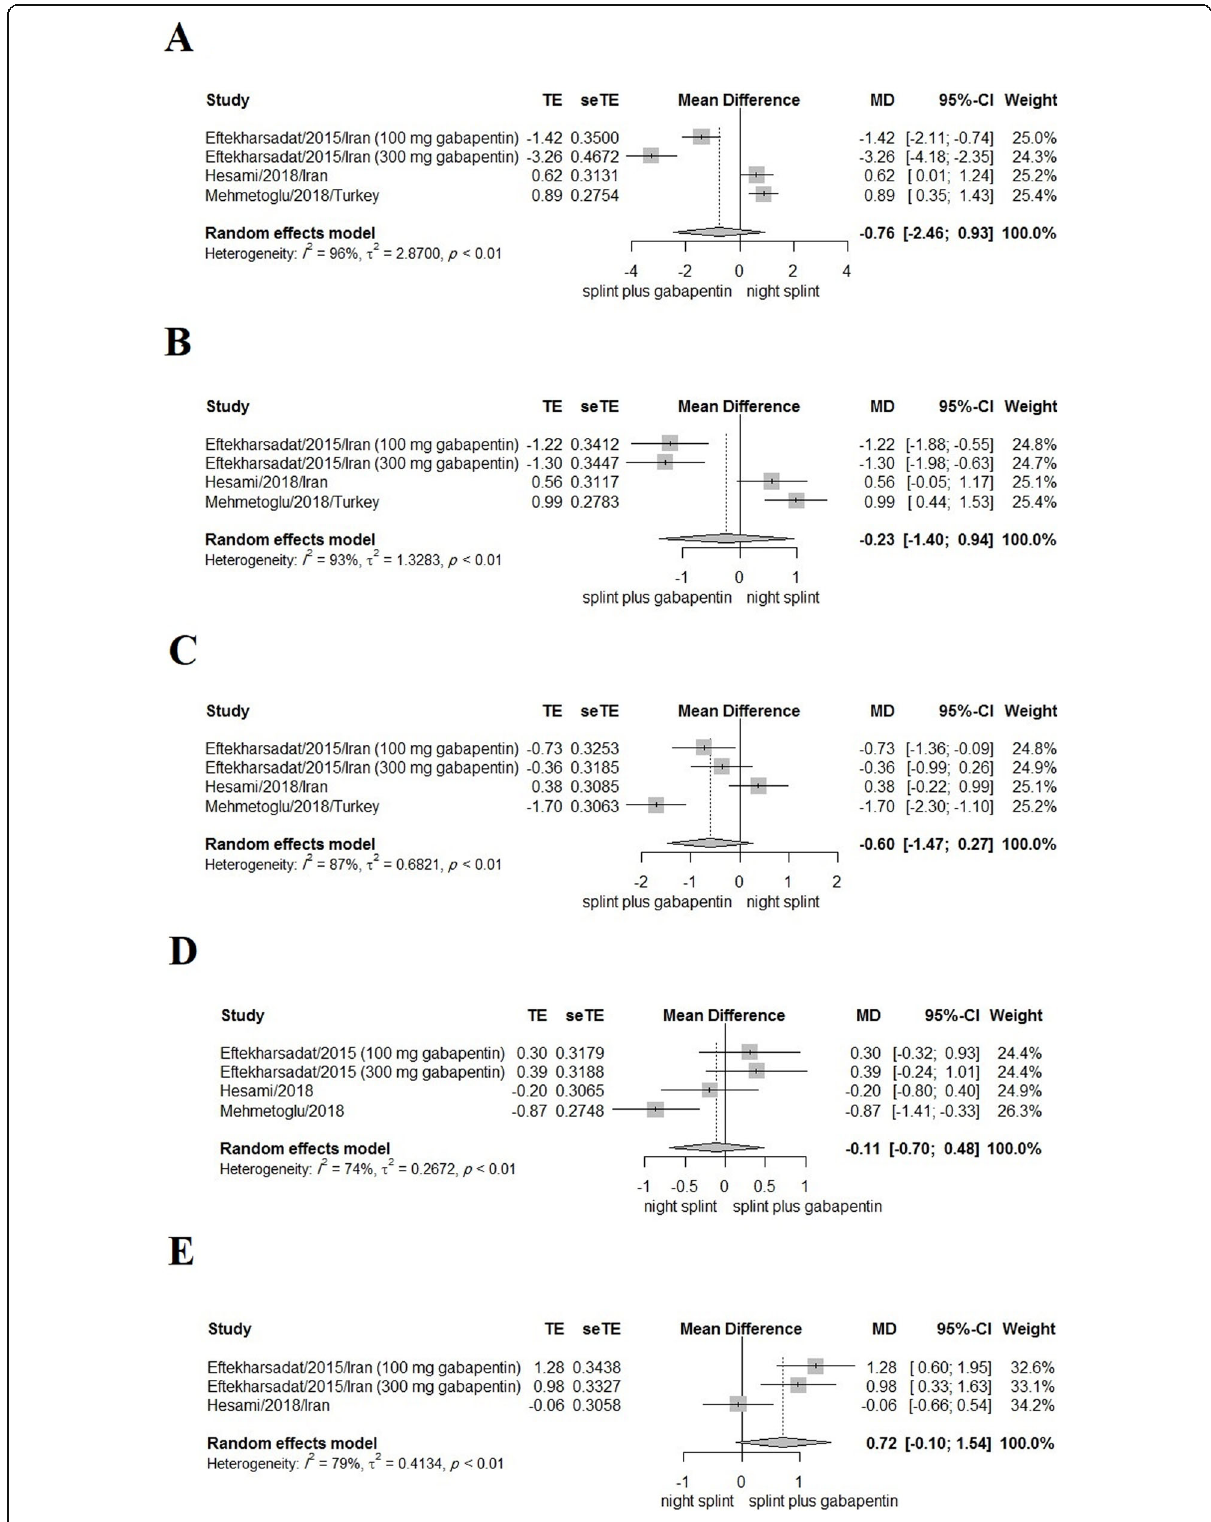
Fig. 3 Forest plot meta-analysis comparing changes in in the measured outcomes between gabapentin and control group; (TE = treatment effect, seTE = standard error of treatment effect): a Symptom Severity Scale (SSS), b Functional Severity Scale (FSS), c visual analogue score (VAS), d grip strength, and e pinch